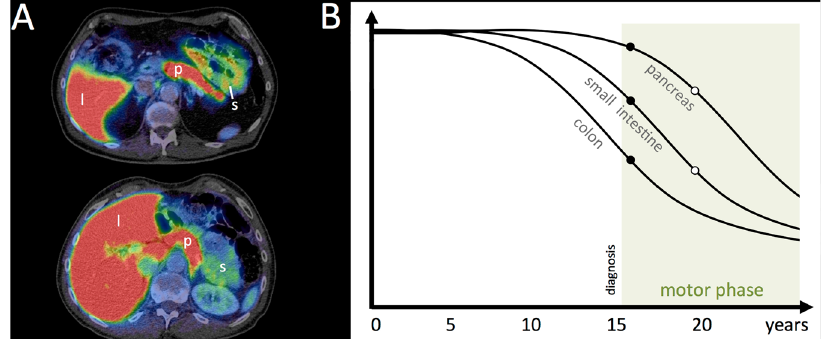
Fig. 2 11 C-donepezil PET/CT images. a Summed PET images superimposed on anatomical CT in a healthy control ( top ) and a PD patient ( bottom ). Note the visually apparent decrease in the small intestine signal. b Hypothetical timeline of parasympathetic denervation during the course of prodromal and manifest PD. Closed and open circles represent 11 C-donepezil PET data from de novo (duration 1 year) and moderate stage PD patients (duration 4.5 years), respectively. 65, 66 Shortly after diagnosis, some 11 C-donepezil signal loss is seen in the small intestine and colon, but not in the pancreas. Five years after diagnosis, progressive signal loss is seen in the pancreas, small intestine, and colon. [l liver, p pancreas, s small